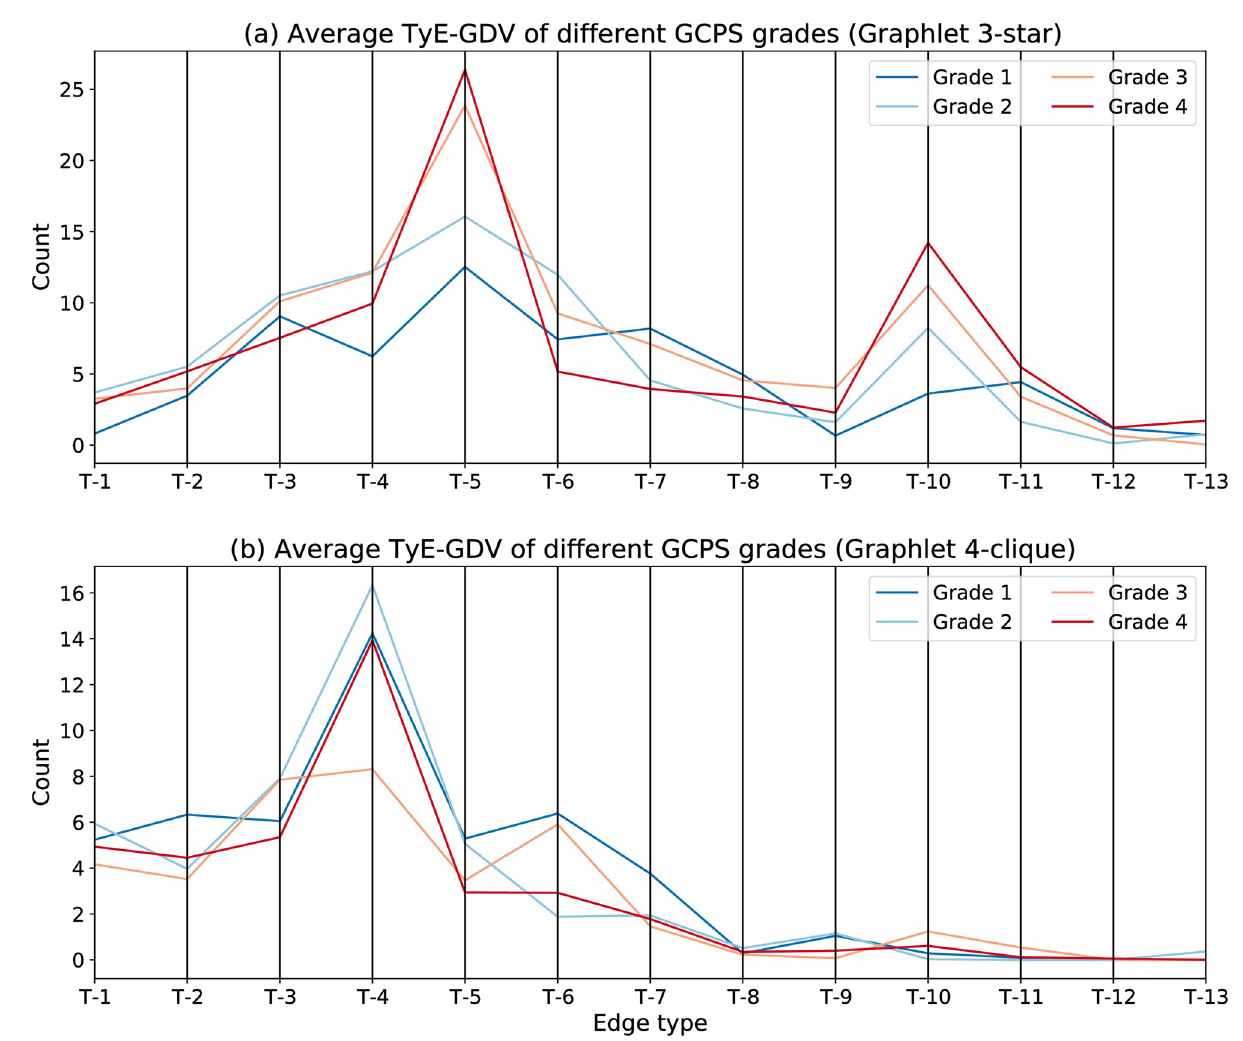
Fig 5. Two parallel coordinates plots revealing the association of edge type and pain grade. (a). Average TyE-GDV of four GCPS grades for 3-star graphlet. (b). Average TyE-GDV of four GCPS grades for 4-clique